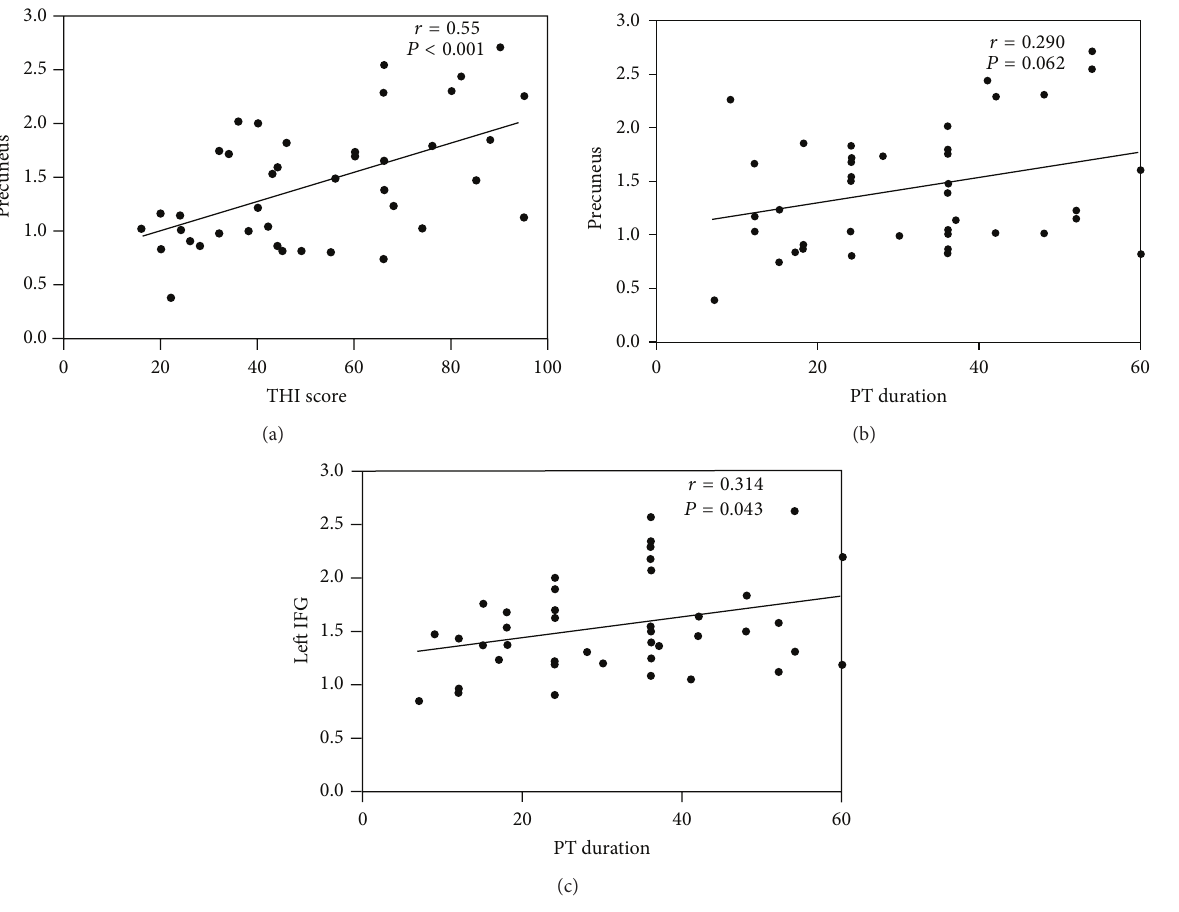
Figure 2: Correlations between THI score, PT duration, and ALFF values in precuneus and left IFG. (a) Correlation between the THI score andALFFvalueintheprecuneus( 𝑟 = 0.549 , 𝑃 < 0.001 ).(b)CorrelationbetweenthePTdurationandALFFvalueintheprecuneus( 𝑟 = 0.290 , 𝑃 = 0.062 ). (c) Correlation between the PT duration and ALFF value in the left IFG ( 𝑟 = 0.314 , 𝑃 = 0.043 ). A similar result was also present in the right IFG ( 𝑟 = 0.342 , 𝑃 = 0.027 ) (not shown here). 𝑟 = Pearson correlation coefficient. IFG = inferior frontal